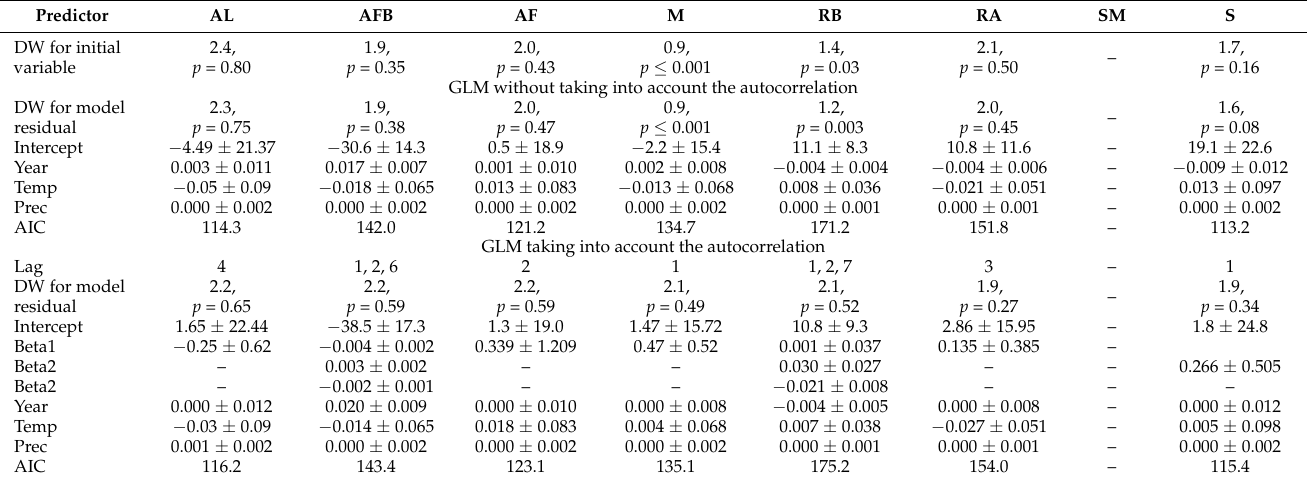
Table 1. Generalized linear models of the time and biotope type effect on the bird community richness and Durbin–Watson test (DW) for time series and model residuals. Beta 1, 2, or 3 are autocorrelation regression terms which correspond lag (or lags) given in the “Lag” line.